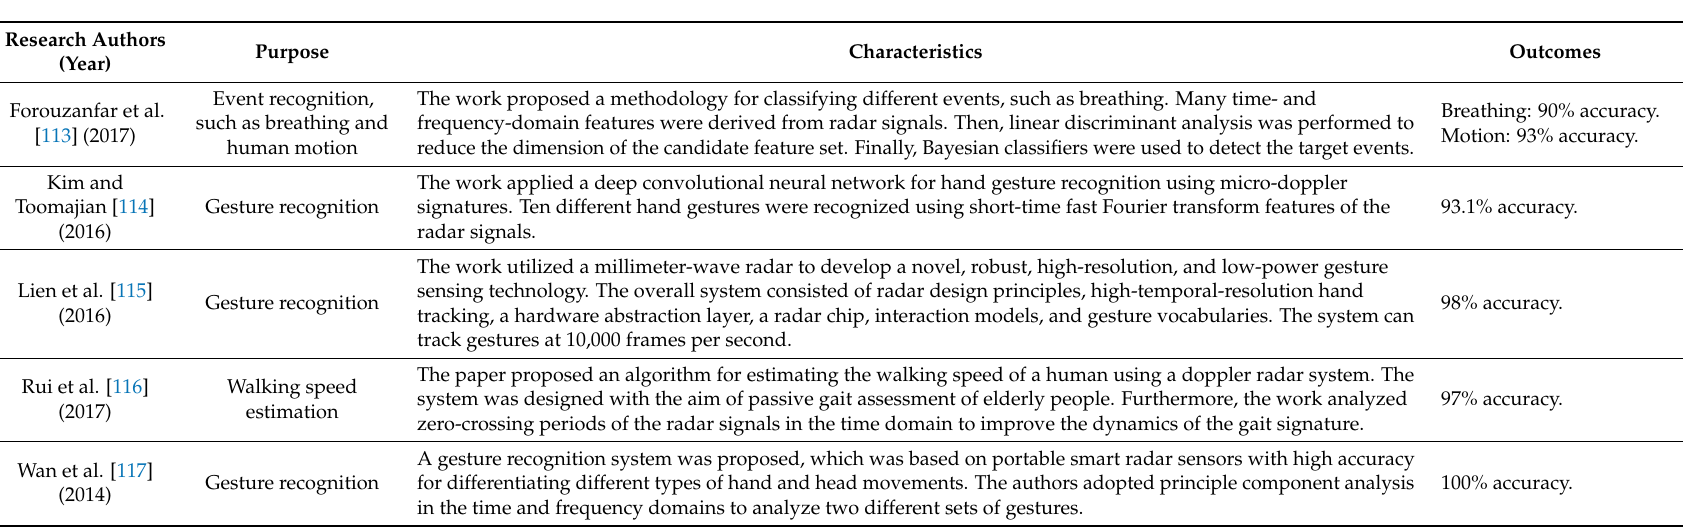
Table 7. Summary of research works that use radar sensor